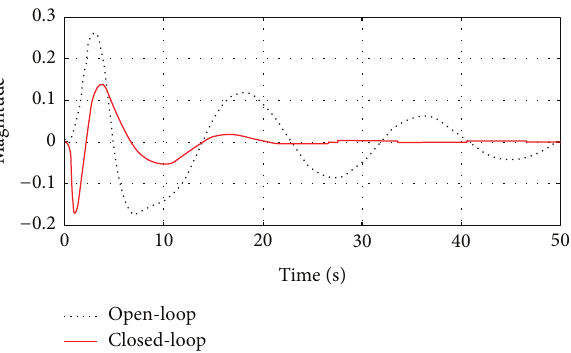
Figure 2: The responses of state variable 𝑥 1 (𝑡)